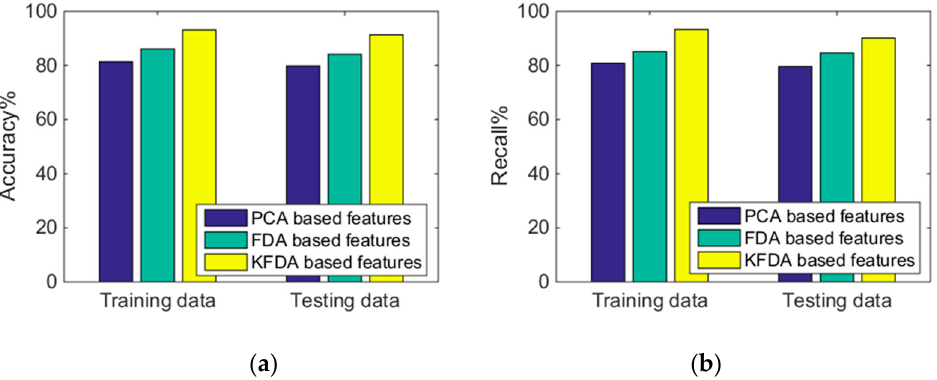
Figure 10. Performance comparison: ( a ) accuracy comparison of the different feature selection methods and ( b ) recall comparison of the different feature selection methods.